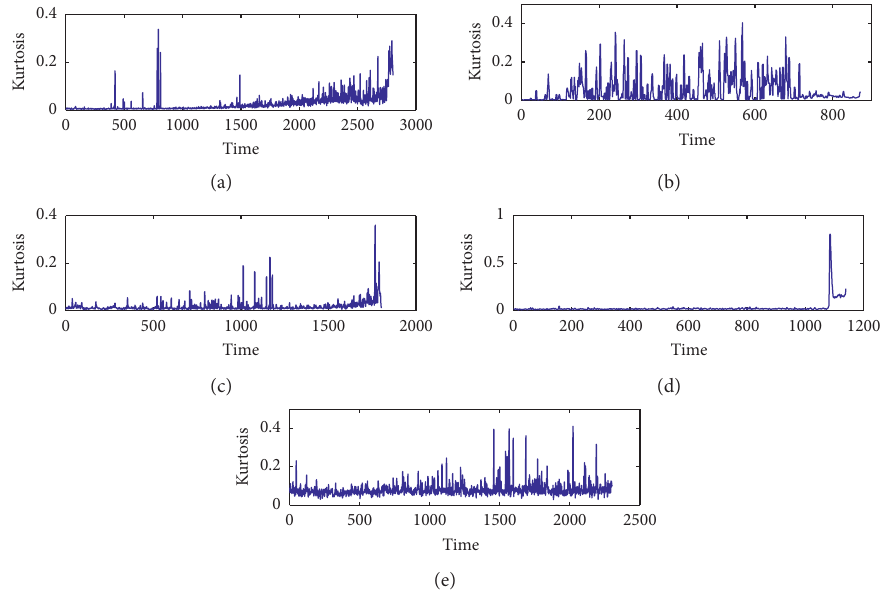
Figure 20: CVs for bearings 11–15 by using kurtosis under various conditions such as “Normal,” “Slight,” and “Severe.” (a) Kurtosis-bearing 11. (b) Kurtosis-bearing 12. (c) Kurtosis-bearing 13. (d) Kurtosis-bearing 14. (e) Kurtosis-bearing